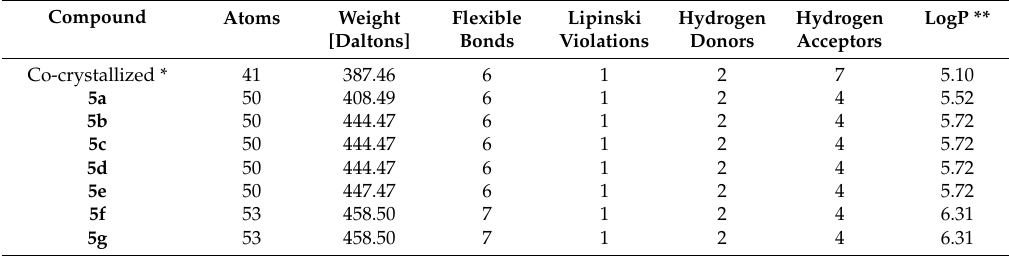
Table 1. Ligands’ molecular properties values.